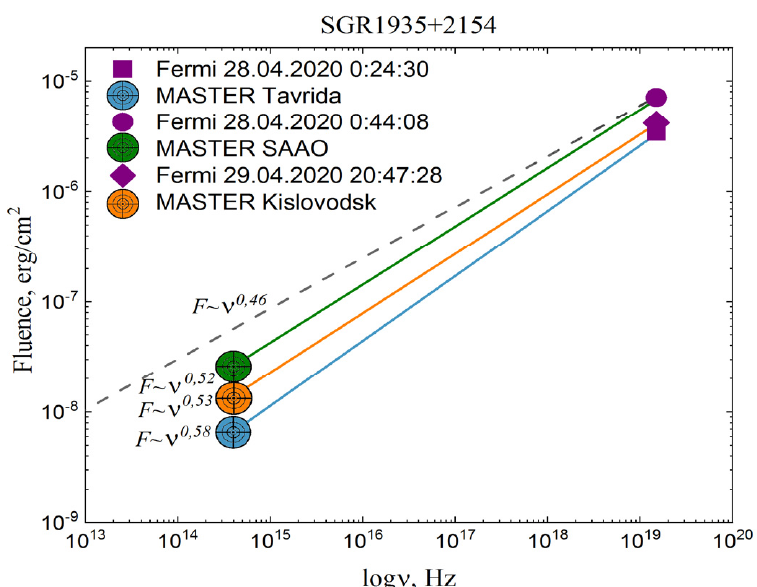
Figure 11. Fluence spectrum of the brightest bursts (Fermi values was taken from [59], MASTER values are our own). Targets show the optical fluence limits obtained by MASTER telescopes, the dashed line corresponds to the power law index deduced from radio and X-ray simultaneous de- tection.